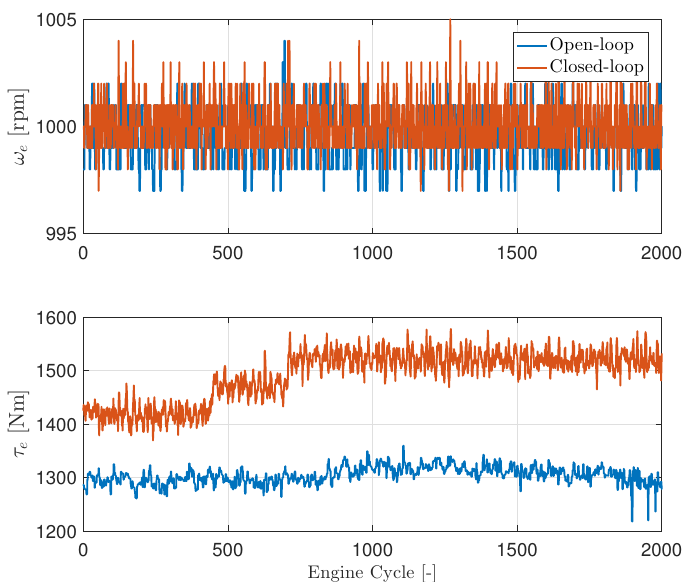
Figure 12. Demonstration of increased RCCI engine load range: open-loop versus closed-loop results (PFI-to-SPI E85 mass flow ratio of